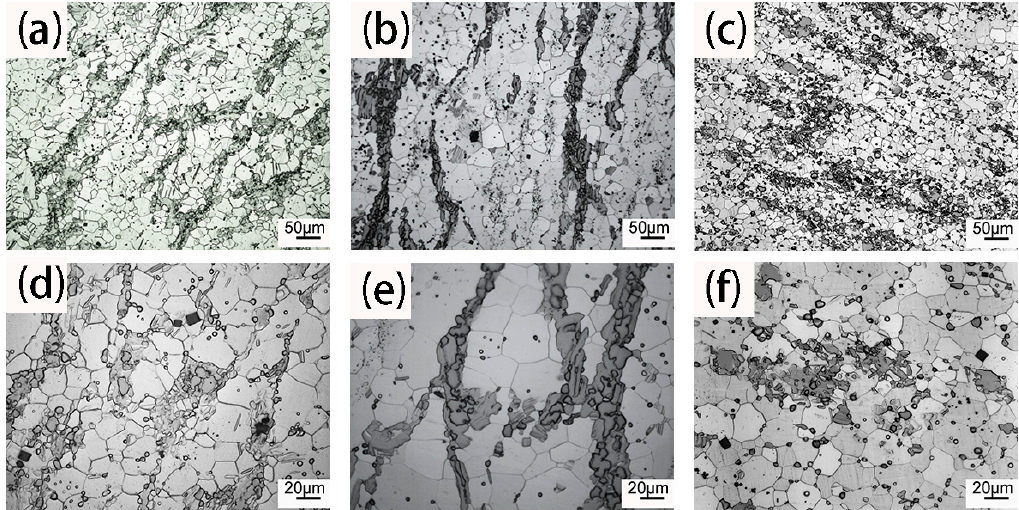
Figure 6. The OM images after annealing treatment of 480 °C for 8 h of ( a , d ) 1MDFed sample; ( b , e ) 2MDFed simple; ( c , f ) 3MDFed simple.